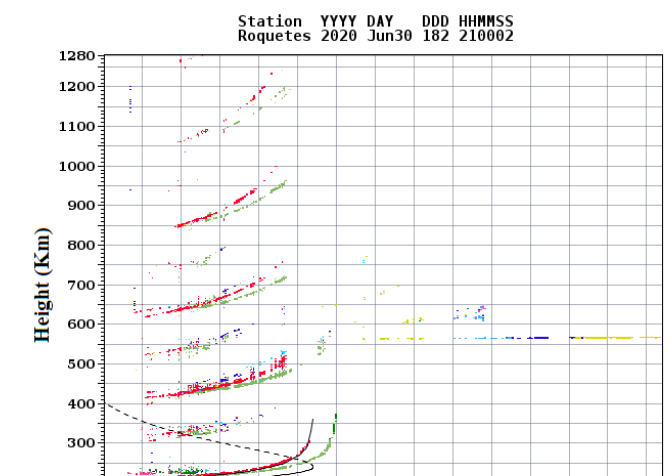
Figure 14. BER CDF vs. Power.